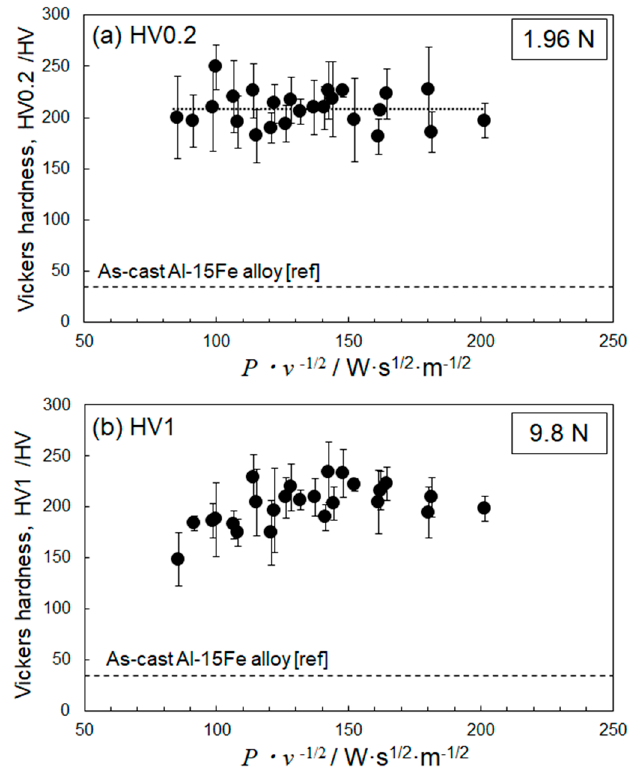
Figure 12. Vickers hardness values of the L-PBF built Al–15%Fe alloy samples measured at ( a ) 1.96 N and ( b ) 9.8 N. The data are plotted as a function of P · v –1/2 based on the deposited energy density.